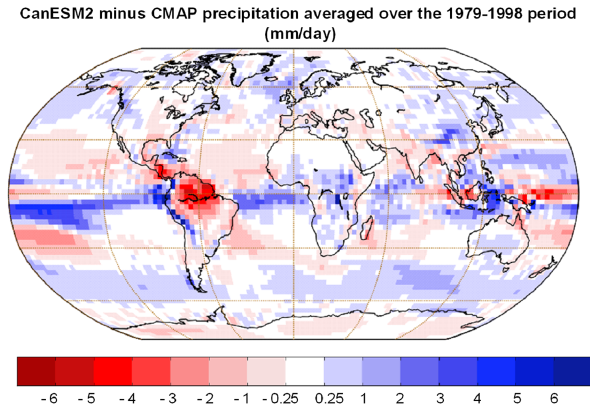
Figure 8. Difference between CanESM2 and observation-based precipitation estimates from CPC Merged Analysis of Precipitation (CMAP) based on Xie and Arkin (1997) averaged over the 1979– 1998